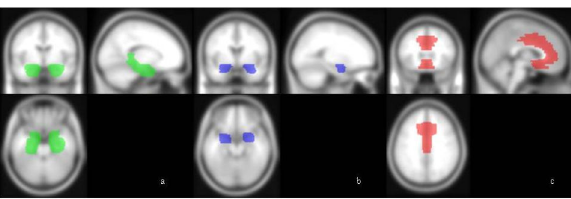
Figure 1. a-c Volumes of interest (VOI). All VOIs are anatomical templates provided by the WFU PickAtlas. Figure 1a shows the hippocampus/parahippocampal gyrus VOI, Figure 1b the amygdala VOI and Figure 1c the ACC VOI. doi: